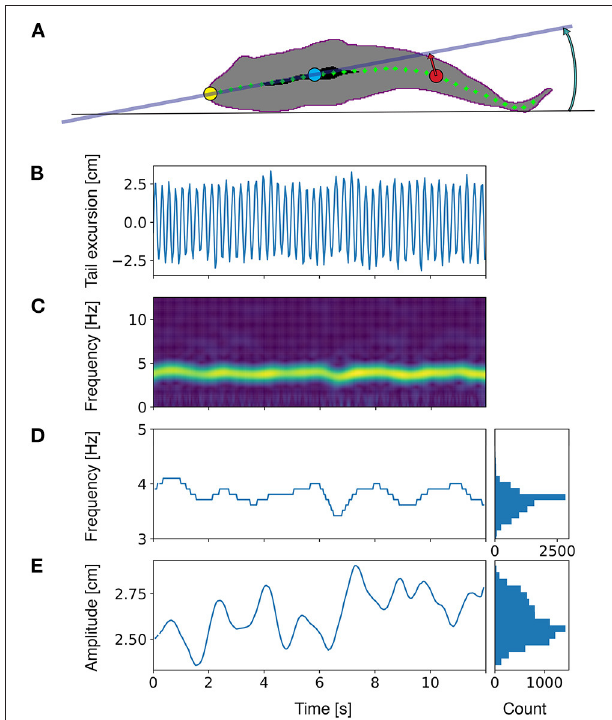
FIGURE 2 | Schematic representation of the locomotion parameters estimated in the present work. (A) bottom view of a fish silhouette with analyzed data points. Yellow: tip of the snout. Blue: reference point in the head region, determined as the center of mass for all points that are located further from the contour than 80% of the width of the fish (the area marked in black). Red: a reference point on the axis of the fish in the tail region, defined at a fixed distance from the snout, along the central axis. Green dots indicate the central axis. (B) Tail excursion as a function of time, measured as the distance of the tail point (red mark) to midline through the head. (C) Frequency analysis of the tail excursion. The spectrogram shows the amplitude of all frequencies as a function of time. (D) The frequency of tail beats determined as the frequency at which the spectrogram peaks. (E) The amplitude of tail excursions determined at the tail beat frequency in (D) . Marginal histograms in (D) and (E) show the distribution of frequencies and amplitudes, from which mean values and standard deviations were calculated. Similar frequency analyses were performed for other parameters (see methods for further